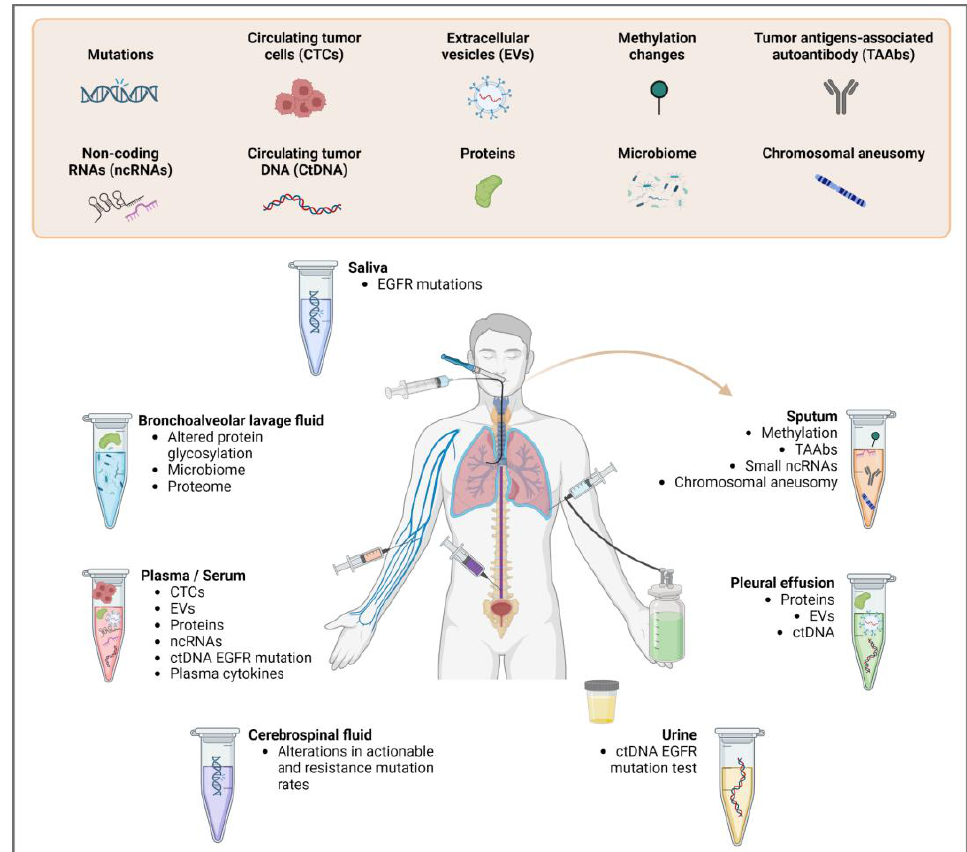
Figure 1. Types of biomarkers used to detect lung cancer in liquid biopsy and the types of bodily fluid samples from which they can be derived. fluid samples from which they can be